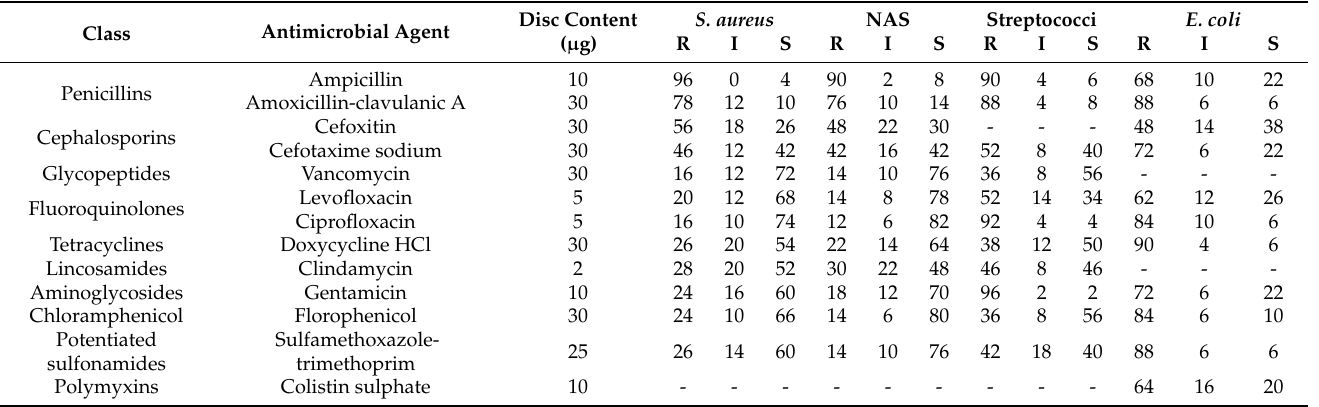
Table 6. Results of antimicrobial susceptibility testing of different bacterial isolates. Class Antimicrobial